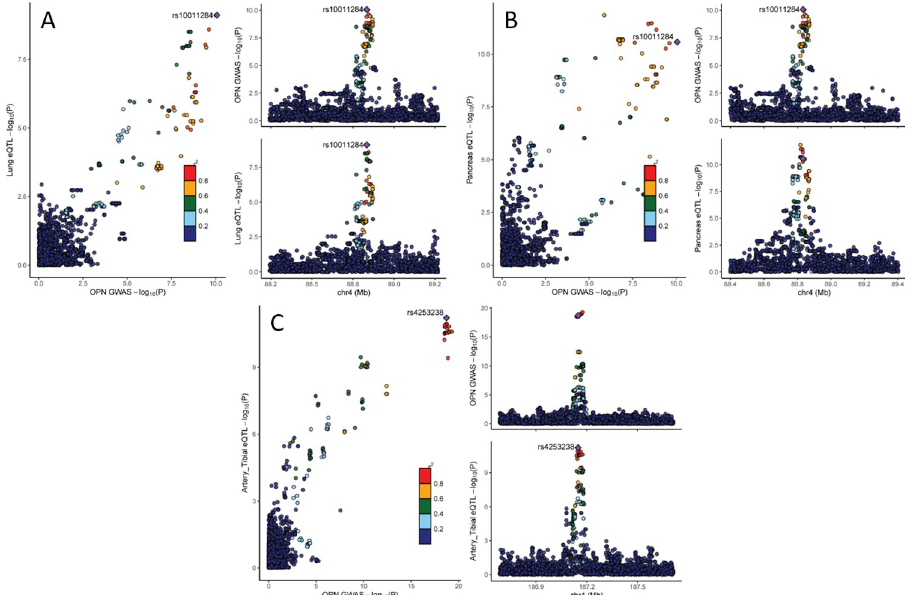
Fig 3. Comparing summary statistics from OPN GWAS and GTEx tissue colocalizing: (A) MEPE : OPN and lung tissue (H4: p12 = 0.99), (B) SPP1 : OPN and pancreas (H4: p12 = 0.85); (C) F11 : OPN and tibial artery (H4: P12 = 0.98). Left: scatter plot comparing association p-values from both sources against each other (-log10 scale). Upper right: OPN GWAS results for the region of interest. Lower right: GTEx GWAS results for the region of interest of respective organ. Colors reflect LD correlation (r 2 ) using 1000G EUR population as